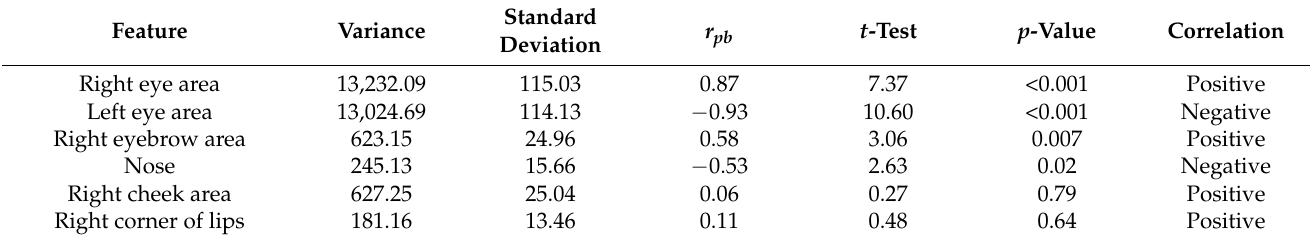
Table 8. Top-five facial attributes correlation with beauty